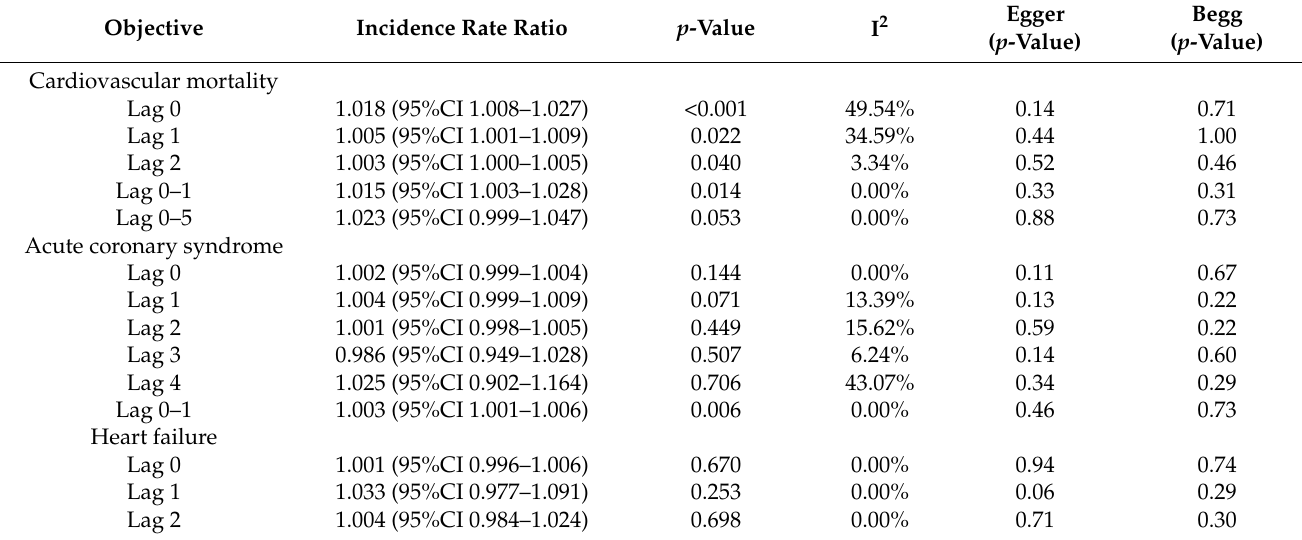
Figure 3. Meta-analysis (forest plot) of the influence of desert dust on cardiovascular mortality (lag 0 = on the same day). IRR: Incidence rate ratio. Table 2. Influence of desert dust on cardiovascular mortality, acute coronary syndrome and heart failure for the different lag days. Lag 0 = same day; lag 1= lag of one day; lag 2 = lag of 2 days; lag 3 = lag of 3 days; lag 4 = lag of 4 days; lag 0–1 = lag of 0–1 day; lag 0–5 = lag of 0–5